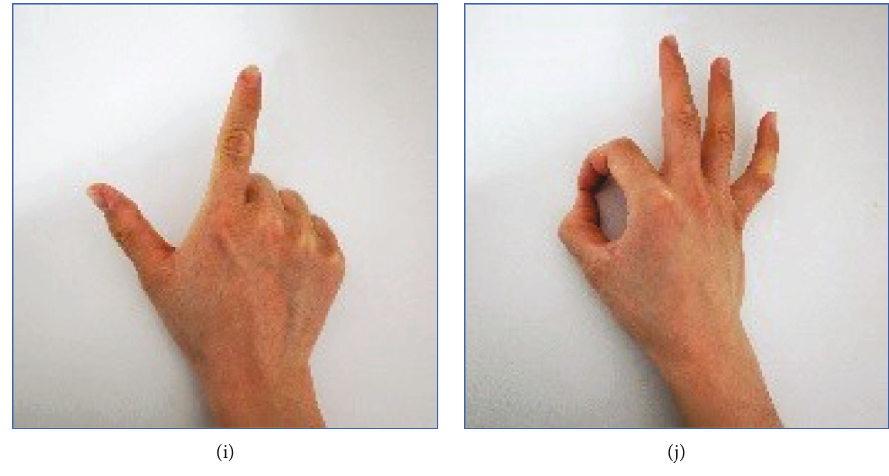
Figure 2: Data acquisition status of the gestures. Table 2: Speci fi c information for 4 subjects.